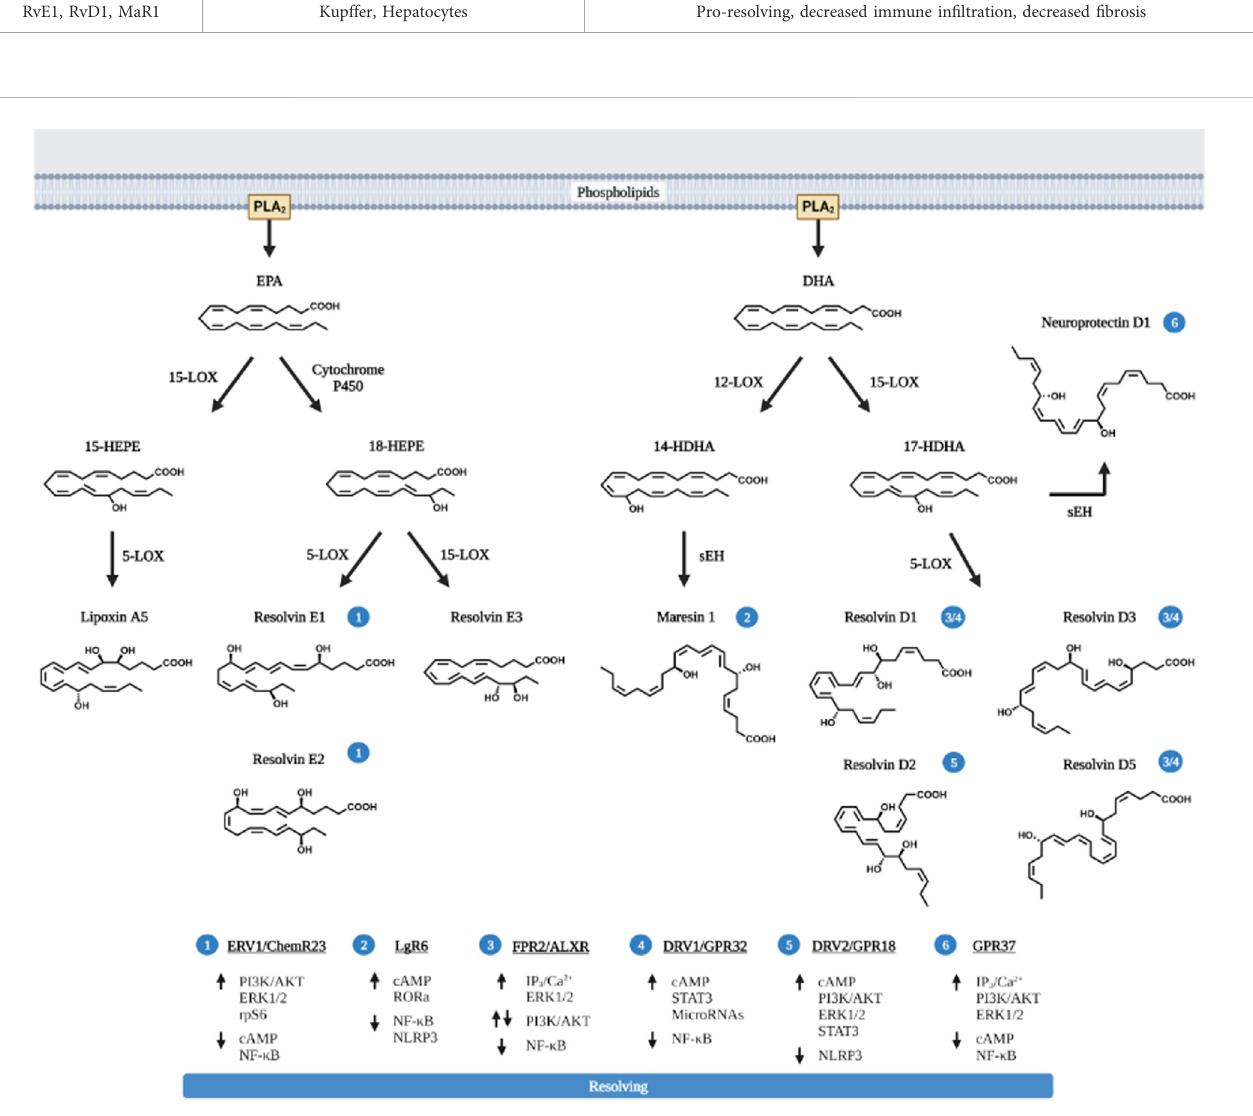
FIGURE 3 Pro-resolving lipids metabolized from EPA and DHA. EPA and DHA are the primary n -3 PUFA substrated of eicosanoid metabolites and are released via PLA 2 . Like AA, EPA and DHA are also metabolized by COX and LOX to produce the pro-in fl ammatory eicosanoids (prostaglandins, thromboxanes and leukotriens, not shown in the fi gure) with less potency compared to those produced from AA. In addition, EPA and particularly DHA produces pro-resolving metabolites. These pro-resolving eicosanoids (lipoxin A5, LXA5) are produced via the action of 12-LOX, similar to LXA4 produced by 15-LOX; or via CYP450 to produce Resolvin E (RvE1, E2 and E3) from EPA. The action of 12-LOX and 15-LOX on DHA produces not only resolvins (RvD1, D2, D3, and D5) but also neuroprotectin D1 and Maresins(MaR). The cellular receptors for each pro-resolving eicosanoids and their respective signaling pathway are presented in the bottom of the fi gure and labeled with circled numbers — near the metabolites. Up arrows indicate enhanced activation, down arrows are indicative of downregulation of signaling pathway. Figure created with